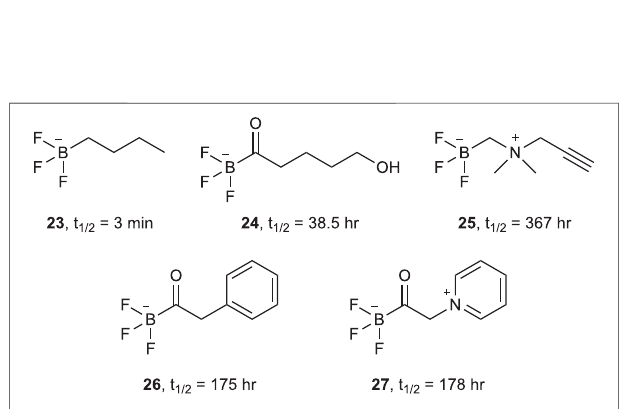
FIGURE 3 | A selection of alkyl- and acyltri fl uoroborates and their half- lives.